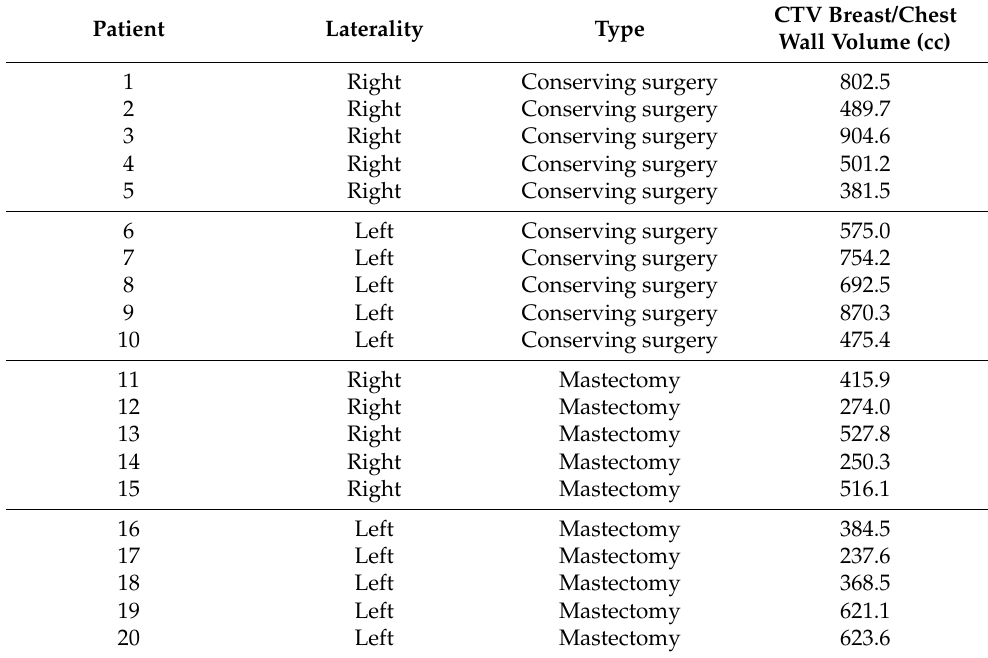
Table 1. Patient characteristics, including treatment side, type of surgery, and volume of breast/chest wall